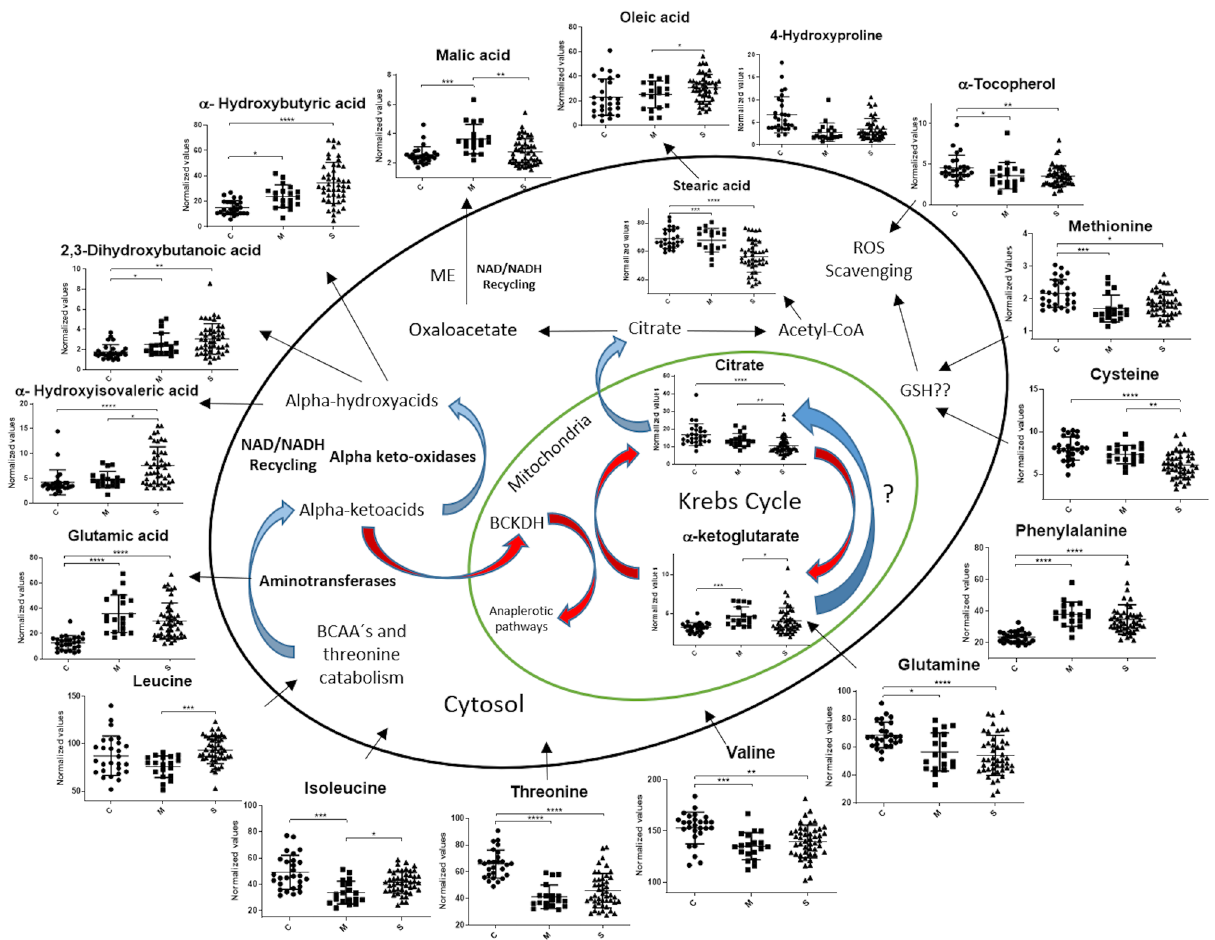
Figure 4. Proposed model for the serum metabolic changes observed in COVID-19 patients. Red arrows represent metabolic flux inhibited during hypoxia. Blue arrows represent increased flux in hypoxia. ME Malic enzyme. The graphs were constructed with the normalized values from control subjects (C), mild (M), and severe (S) patients. Asterisks indicate statistical significance according to the Dunn test. p * < 0.05 ** < 0.01, *** < 0.001, **** <